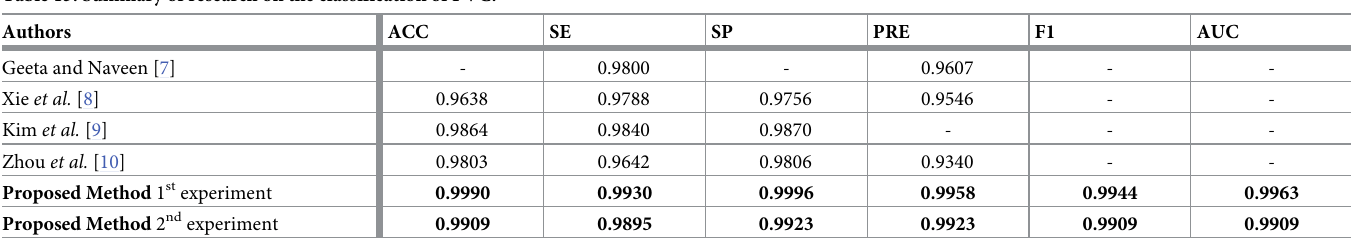
Table 13. Summary of research on the classification of